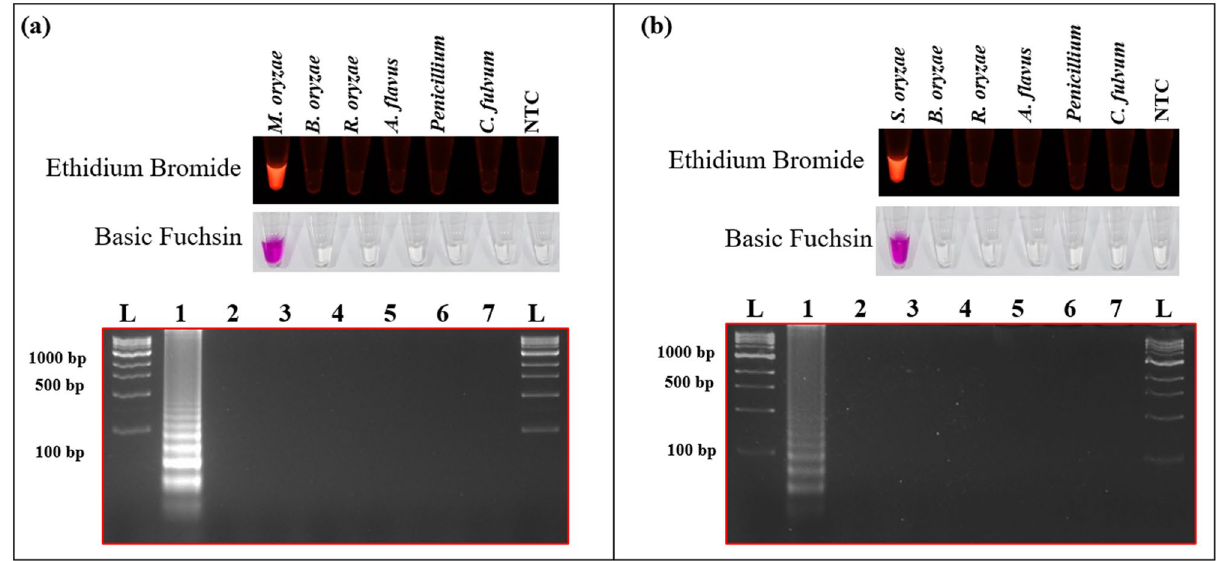
Figure 3. The specificity of LAMP assay. The specificity of the LAMP assay was validated for ( a ) Magnaporthe oryzae and ( b ) Sarocladium oryzae against Bipolaris oryzae, Rhizopus oryzae, Aspergillus flavus, Cladosporium fulvum, and Penicillium sp . using ethidium bromide and basic fuchsin. NTC indicates non-template control.